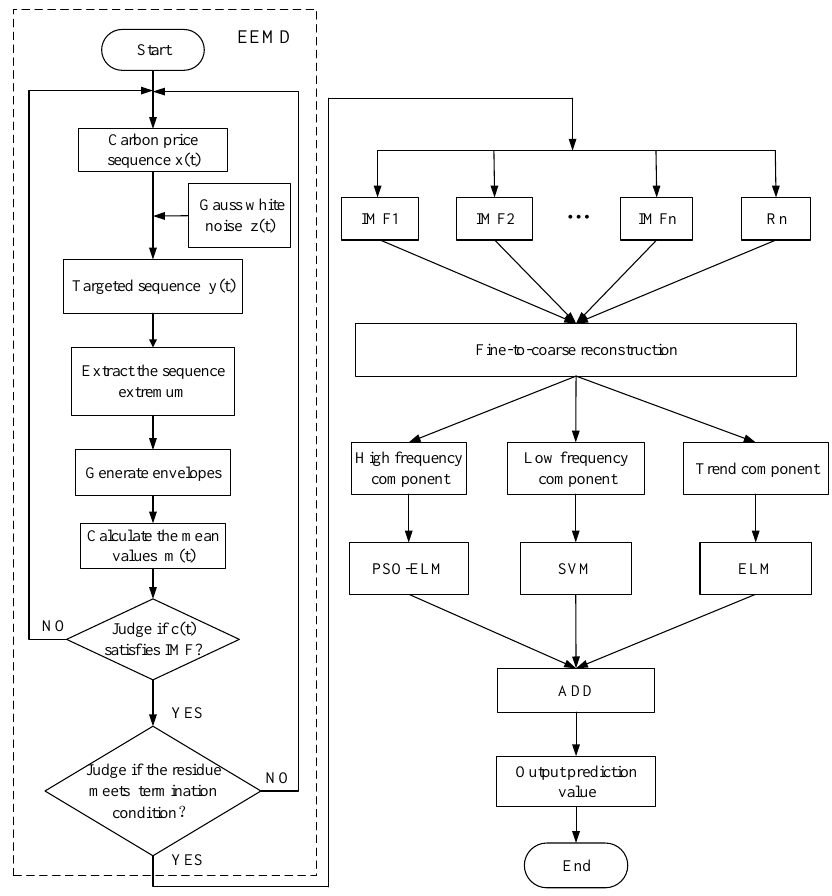
Figure 1. The framework of the proposed ensemble empirical mode decomposition (EEMD-ADD)